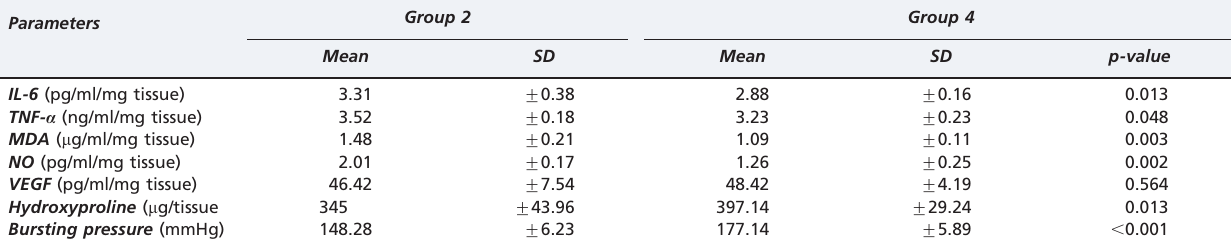
Table 2 - Biochemical assessment and bursting pressures in groups 2 and 4, sacrificed on postoperative day 7.